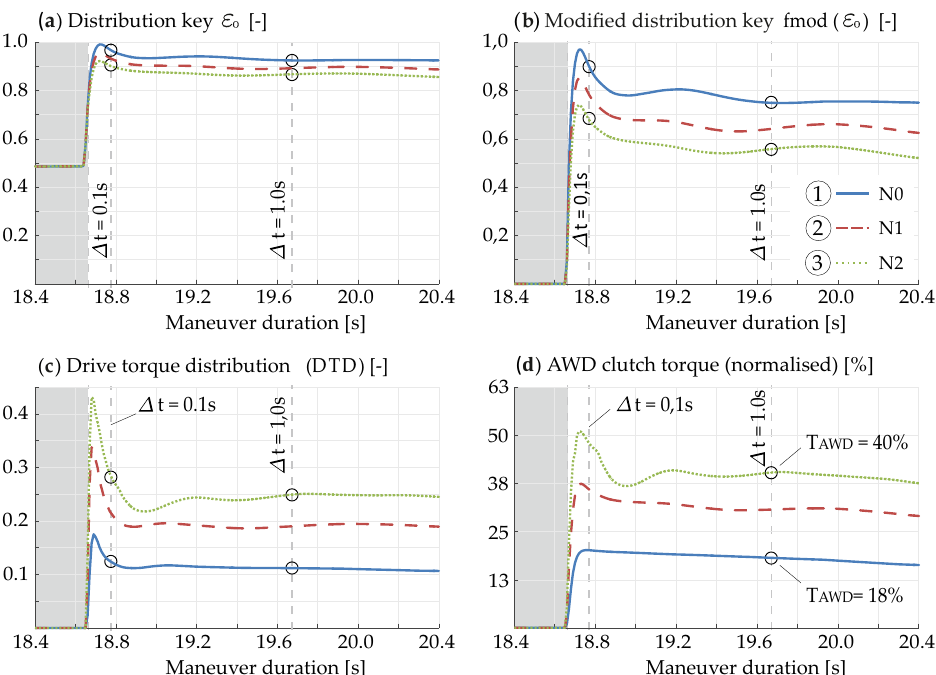
Figure 14. Internal controller parameters during “Power On Cornering“ maneuver ( R = 60 m, a y 0 = 6m/s 2 ) on wet road ( µ max = 0.6): ( a ) distribution key ε 0 ; ( b ) modified distribution key f mod ( ε 0 ) ; ( c ) drive torque distribution; ( d ) AWD clutch